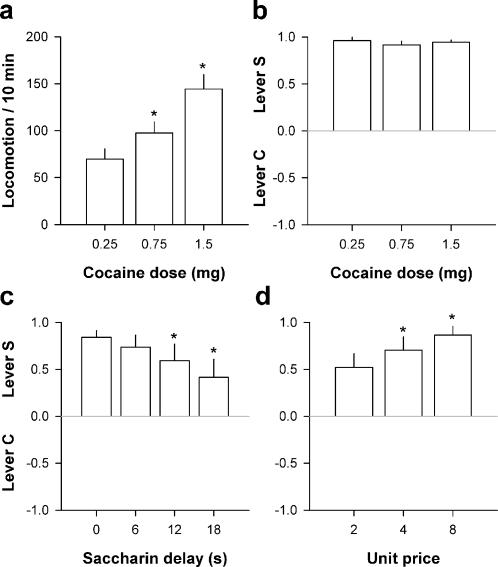
Pharmacological and economic determinants of cocaine choice.a, Cocaine-induced locomotion as a function of dose. Locomotion (i.e., mean number of cage crossings±SEM) was measured during 10 min after the first cocaine self-injection of the first day of each dose substitution. b, Choice between levers C and S (mean±SEM) as a function of dose. c, Choice between levers C and S (mean±SEM) as a function of delay between response and saccharin delivery. *, different from the shortest delay (P<0.05, Fisher's LSD test after one-way ANOVA). d, Choice between levers C and S (mean±SEM) as a function of reward price. *, different from the lowest price (P<0.05, Fisher's LSD test after one-way ANOVA). The values of each variable (dose, delay and price) were tested at least 5 times in a row until stabilization of behavior. Bars represent the means of the last 3 stable days.